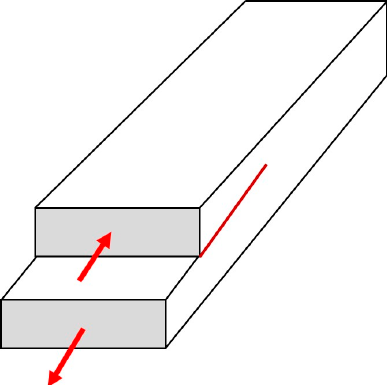
Figure 4. “Mode II” crack propagation for in-plane shear loading, red arrows showing applied forces.